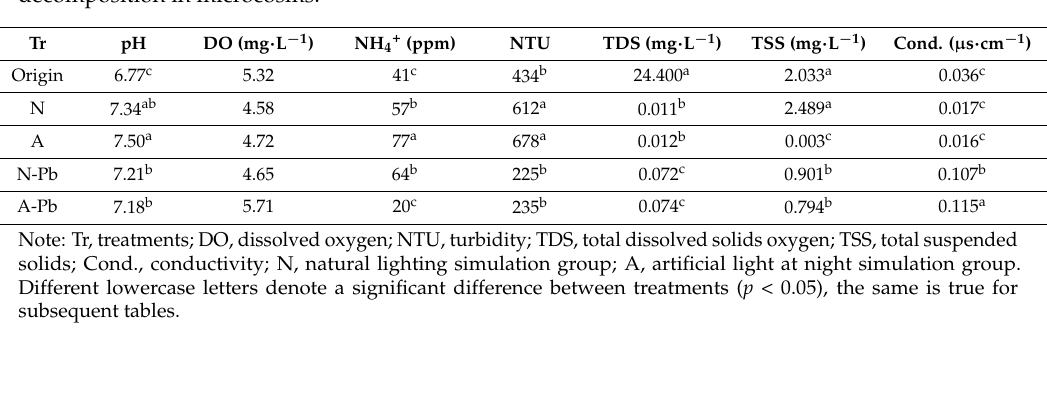
Table 1. Hydrographical and chemical characteristics of stream waters during leaf immersion and decomposition in